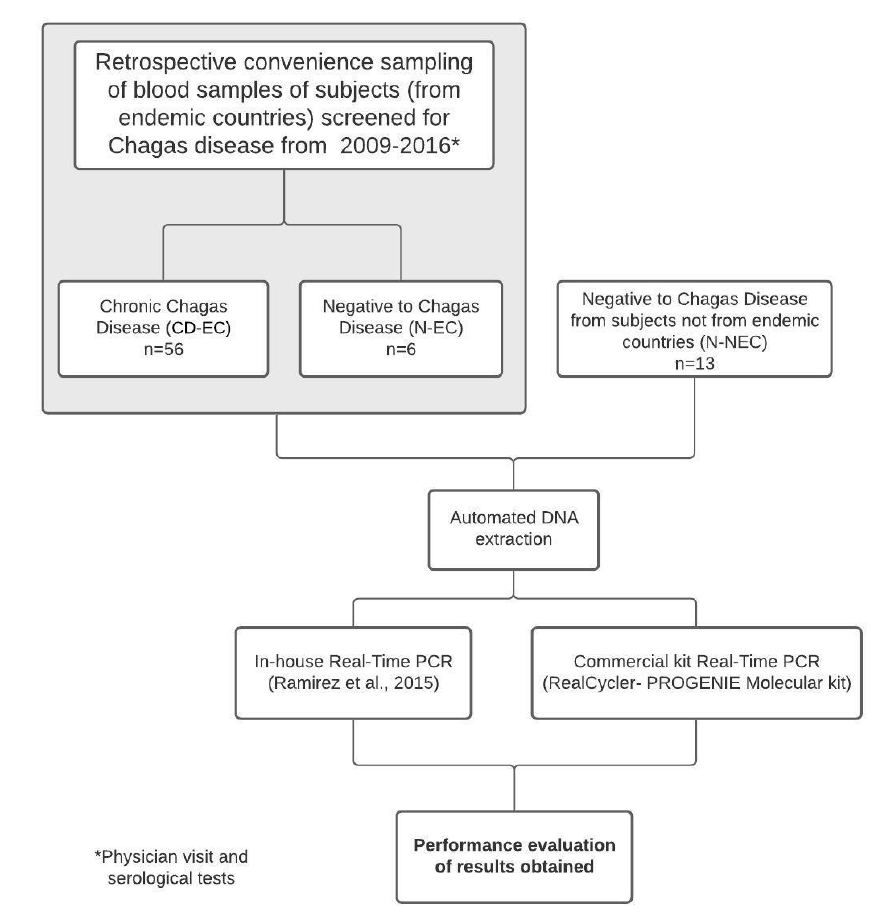
Figure 1. Study flowchart. CD-EC: Chronic Chagas disease from endemic country; N-EC: Negative from endemic country; N-NEC: Negative from nonendemic country .